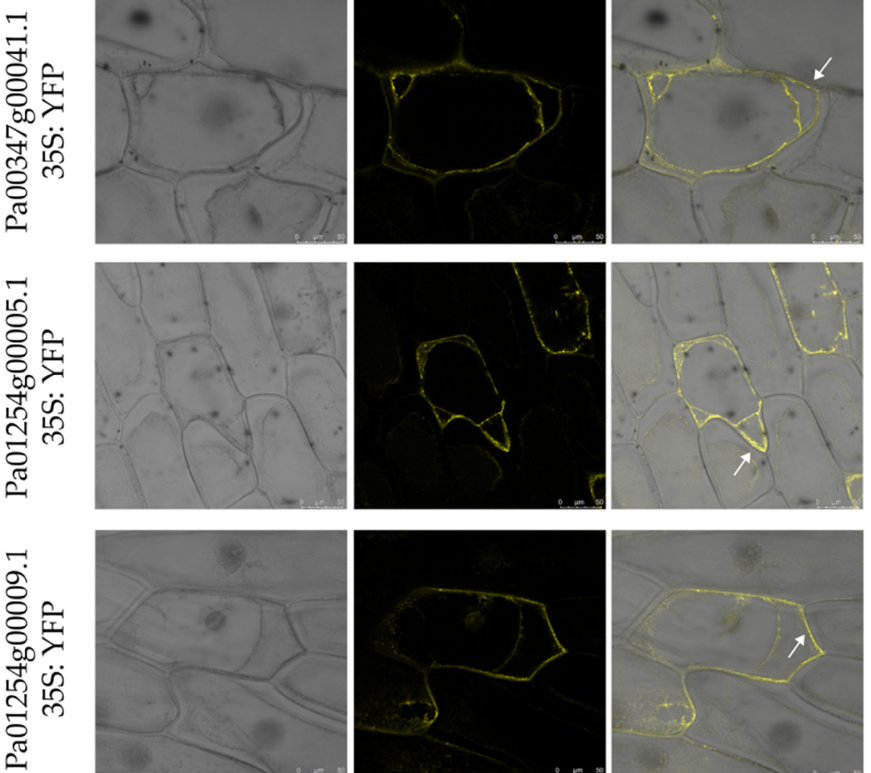
Figure 9. Subcellular localization of four PaCTLs-yellow fluorescent protein (YFP) fusion proteins in onion epidermal cells. The middle row show fluorescence images of plasmolyzed transgenic cells. The fluorescence signal can be observed in the cell wall (white arrows). The left column are bright-field images of the corresponding onion epidermal cells. Scale bars = 50 µm.